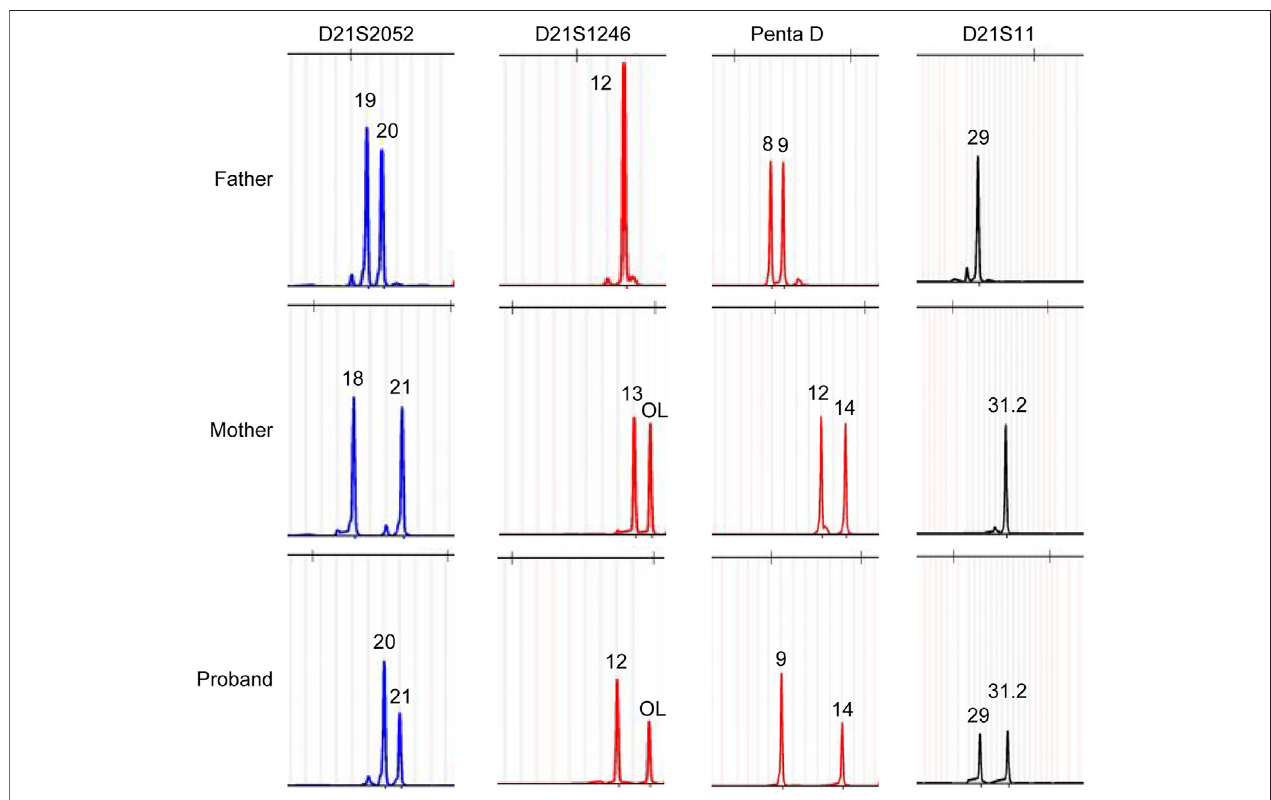
FIGURE 3 | Polymorphic Chr21 speci fi c DNA marker analysis showed a paternal origin of the extra chromosome 21 fragment.